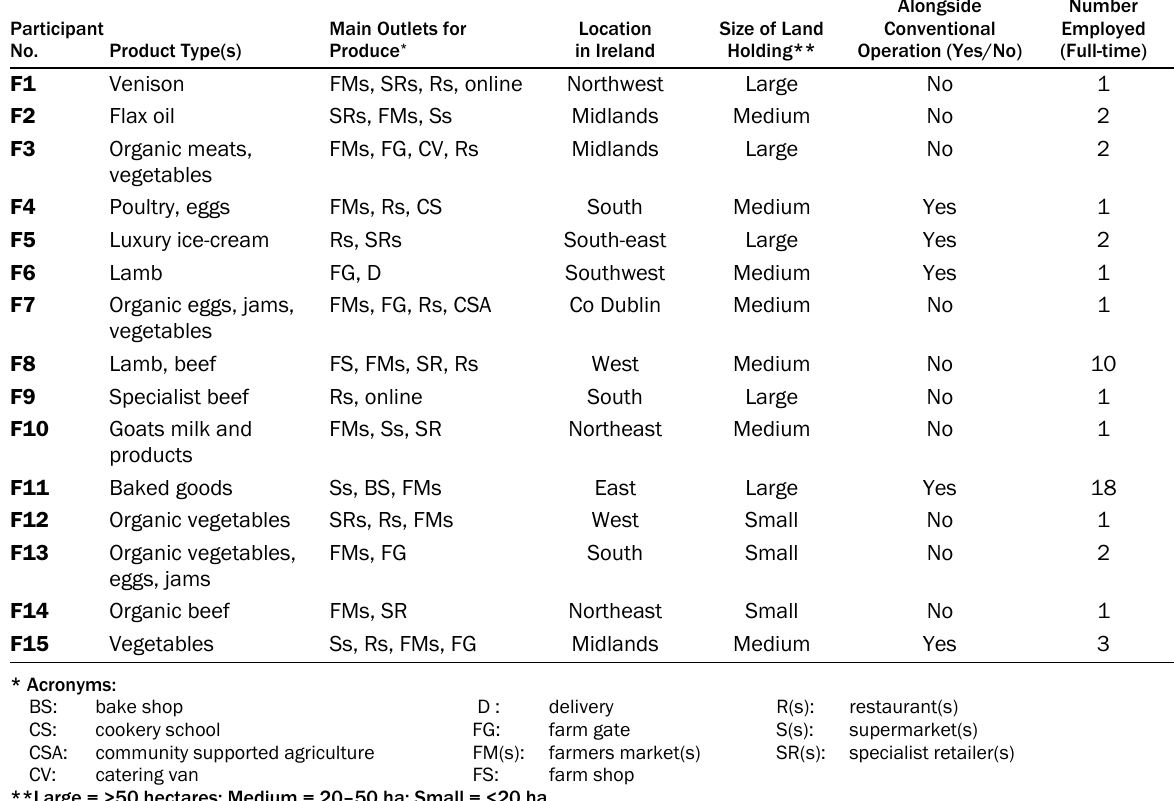
Table 1. Profiles of Farm Businesses in the